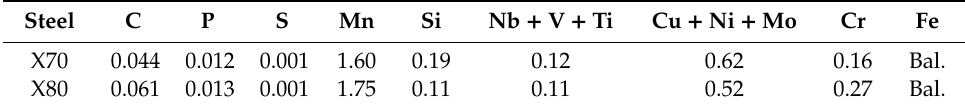
Table 1. Chemical composition of steel